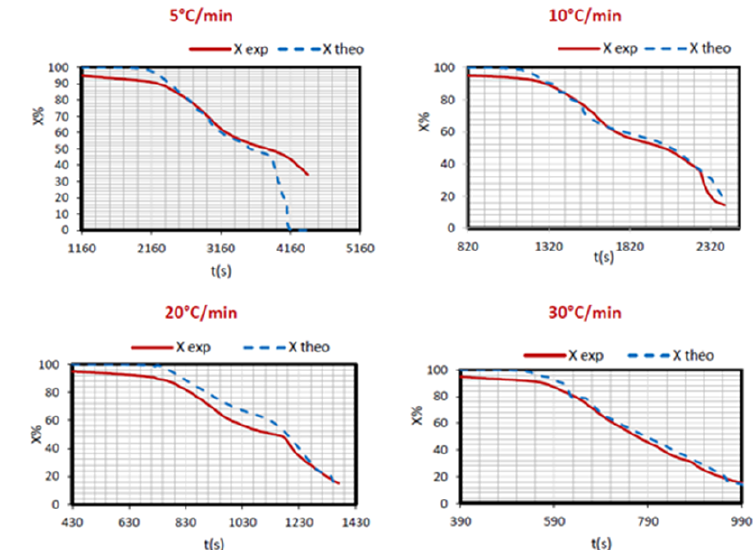
Figure 4. Mass loss fraction validation profiles.